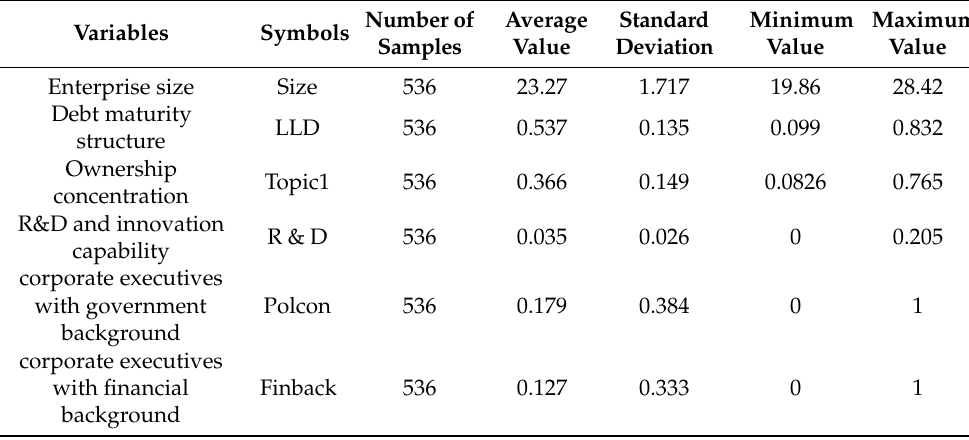
Table 7. Internal influencing factors and descriptive